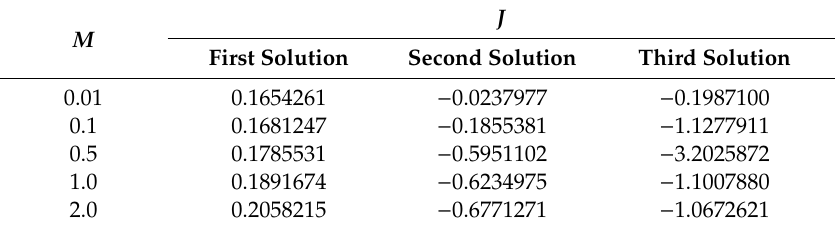
Table 5. Value of J as M varies at Pr = 30, We = 0.2, n = 0.6, S = − 0.3, and σ = 1.2.